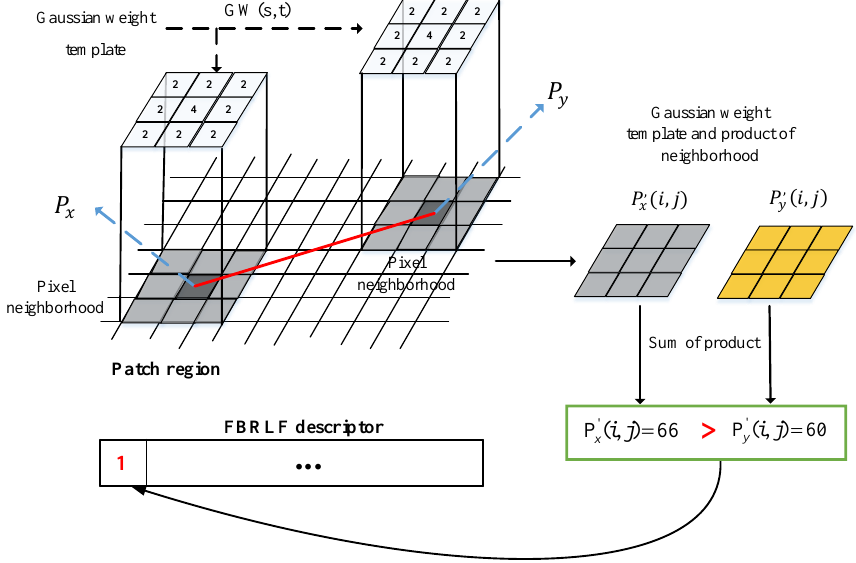
Figure 12. FBRLF feature description. The red line is one of the lines from the patch.